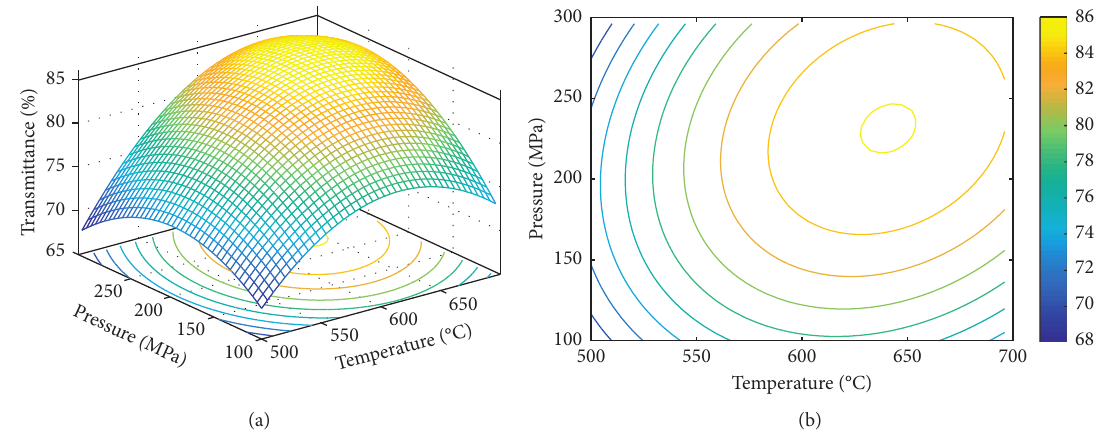
Figure 6: The optimal transmittance surface depends on the temperature and